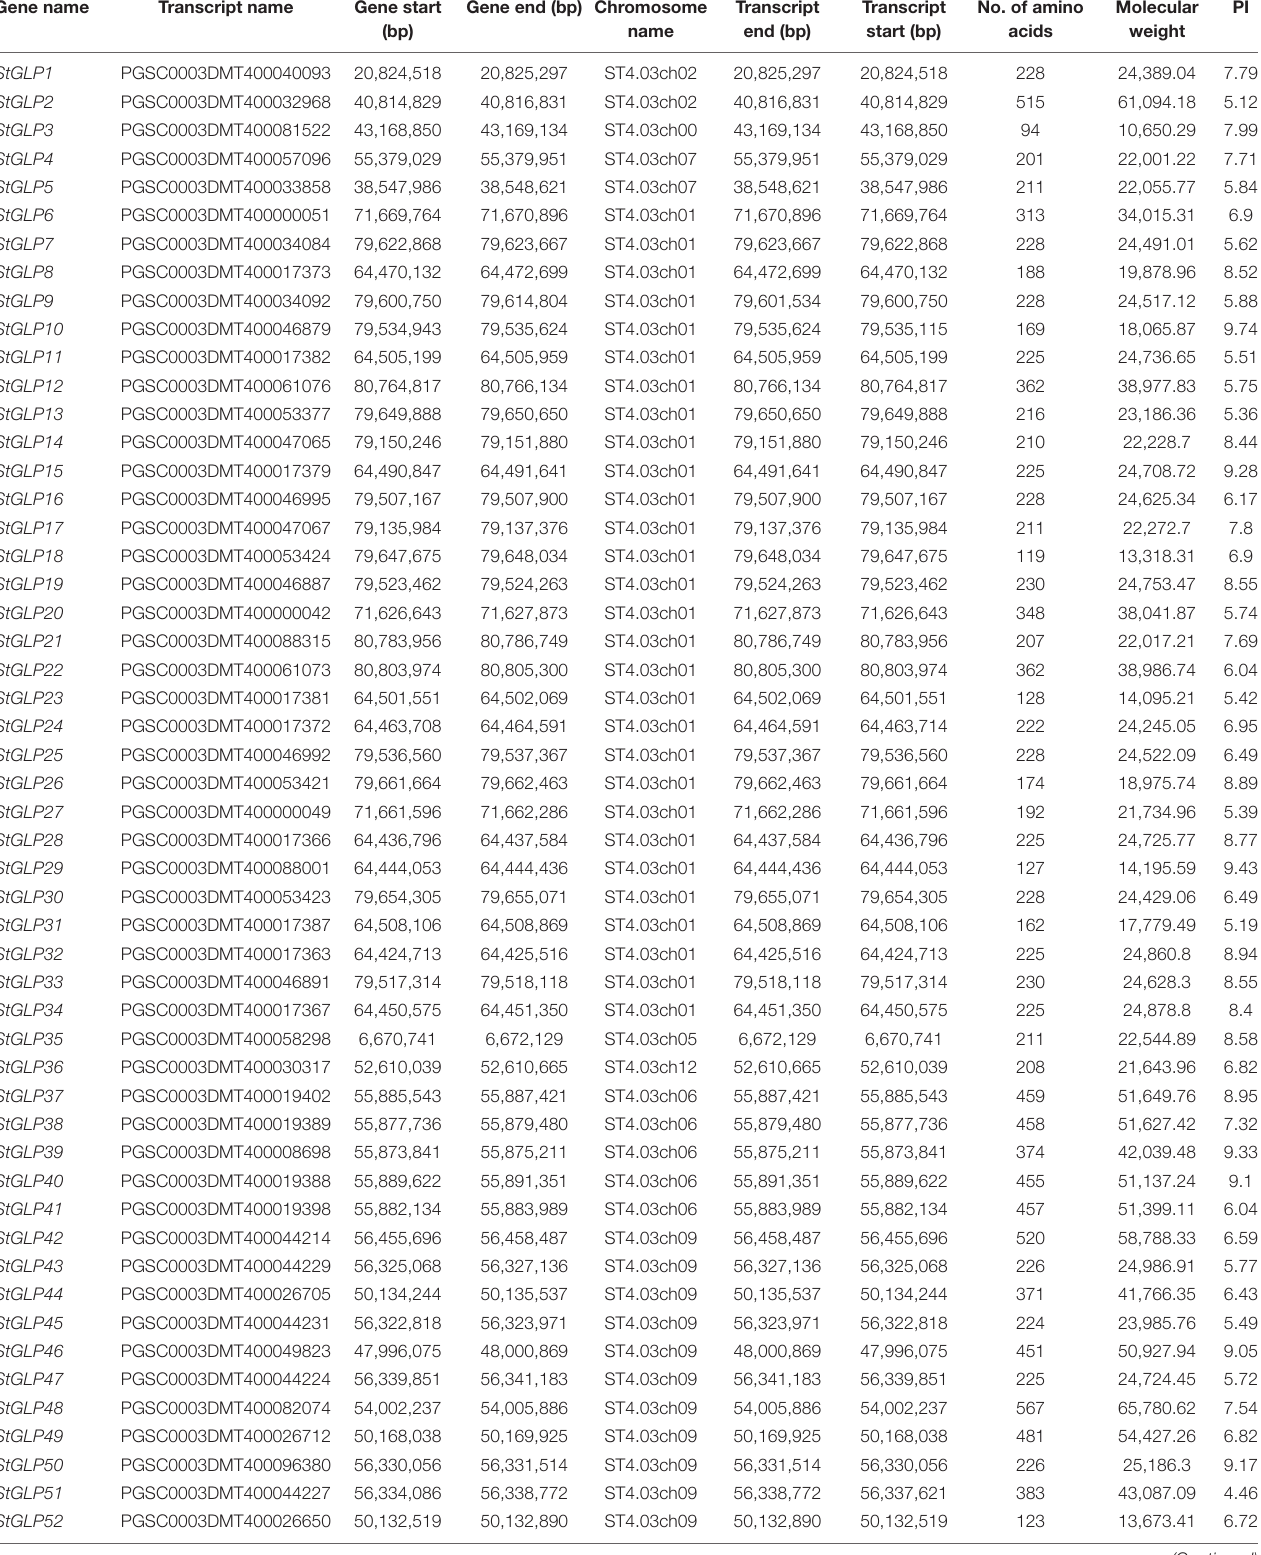
TABLE 1 | List of identified putative StGLPs and their